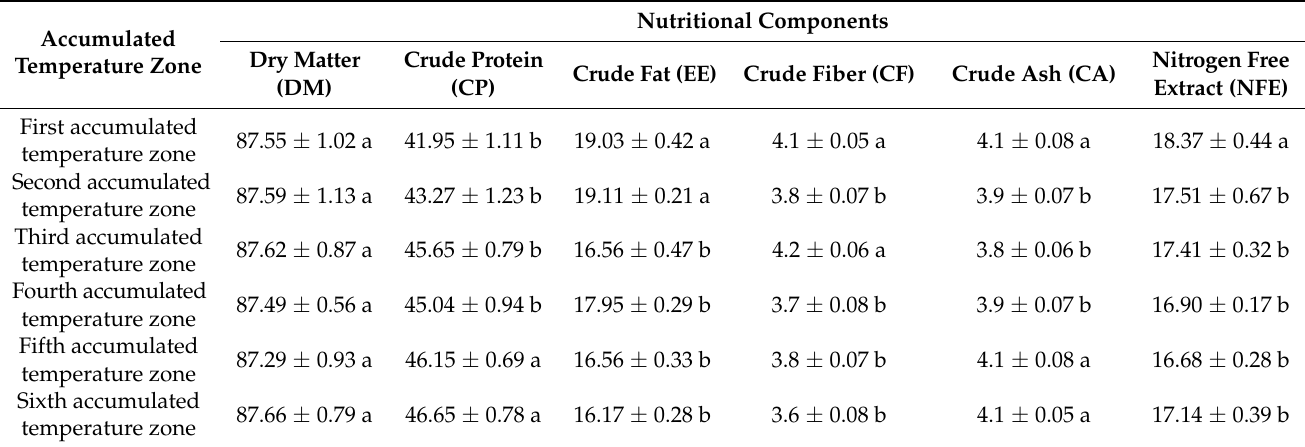
Table 1. Analysis of nutritional components (mean ± standard deviation) of wild soybeans from different accumulated temperature zones.